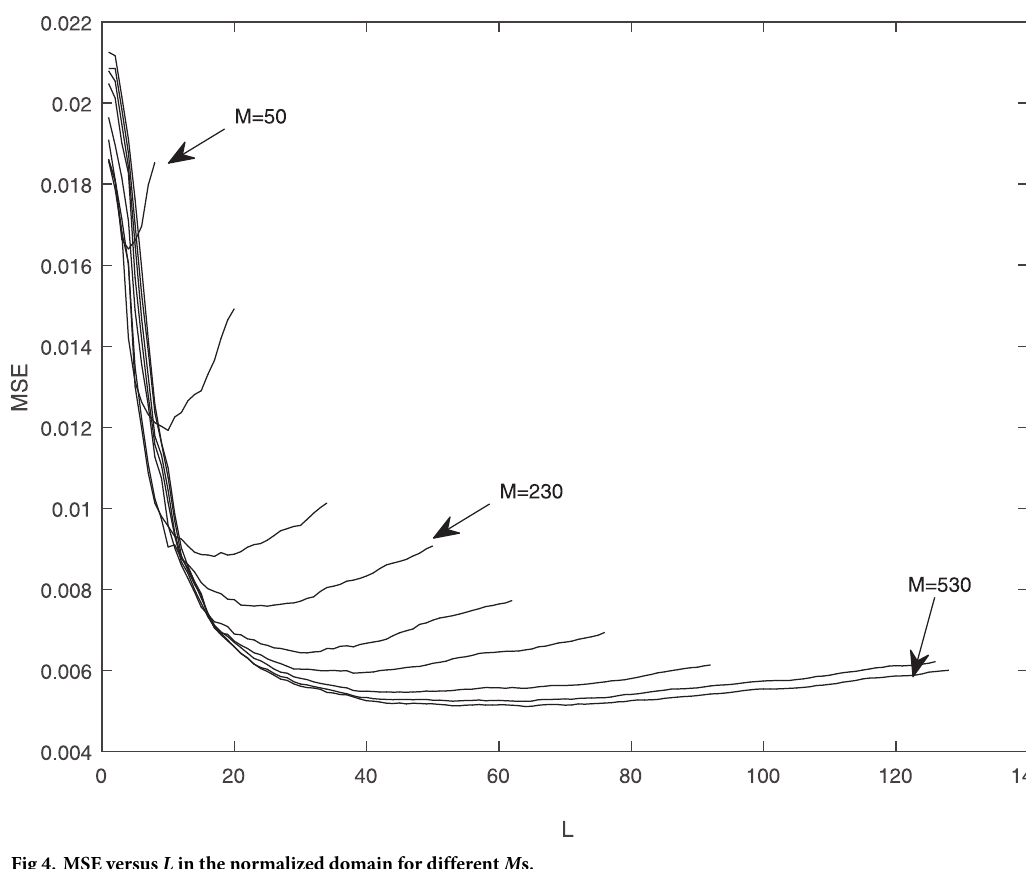
Fig 4. MSE versus L in the normalized domain for different M